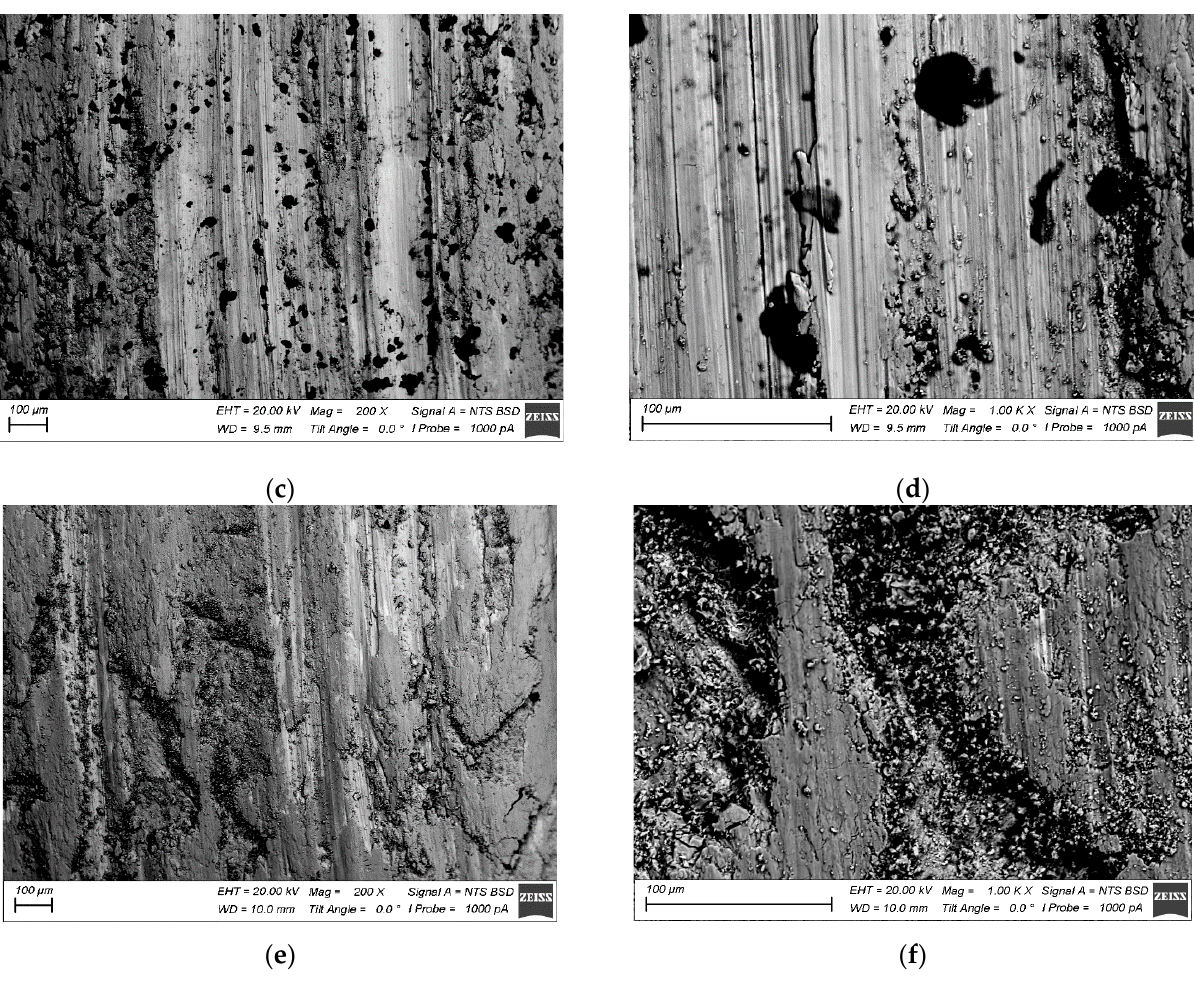
Figure 18. Worn surfaces of Ti6Al4V ( a , b ), 4-pass Ti6Al4V ( c , d ), and 6-pass Ti6Al4V/Cu ( e , f ).